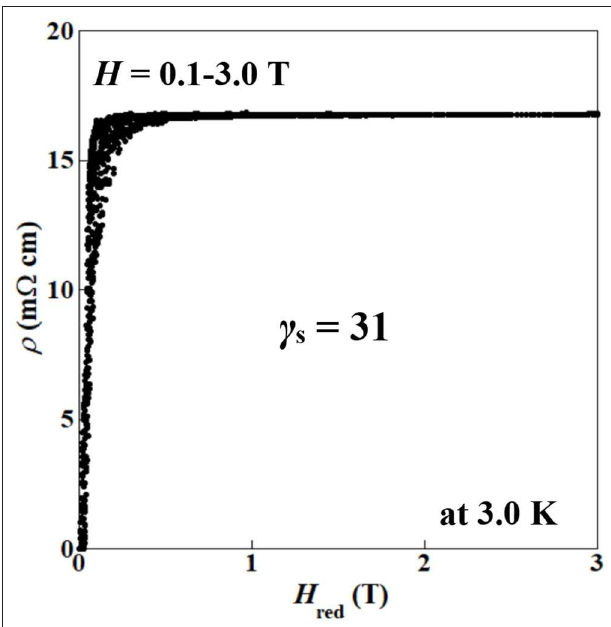
FIGURE 11 | Reduced magnetic field H red dependence of resistivity ( ρ ) scaling by Equation (1): H red = H (sin 2 θ + γ − 2 s cos 2 θ ) 1 / 2 using Figure 10 data.